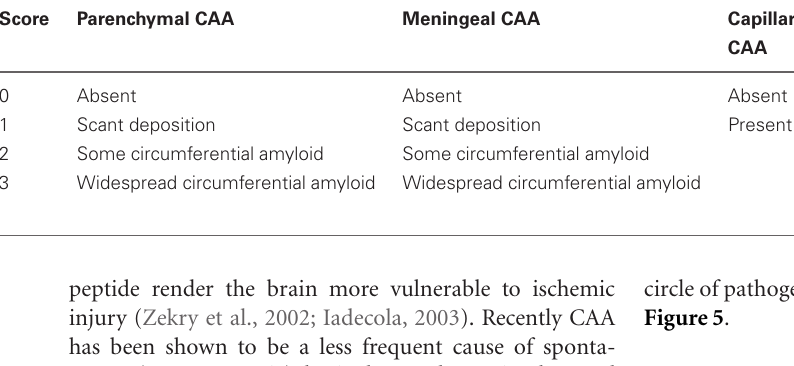
Table 8 | Suggested protocol for the assessment of cerebral amyloid angiopathy and concomitant vasculopathy (Chalmers et al.,